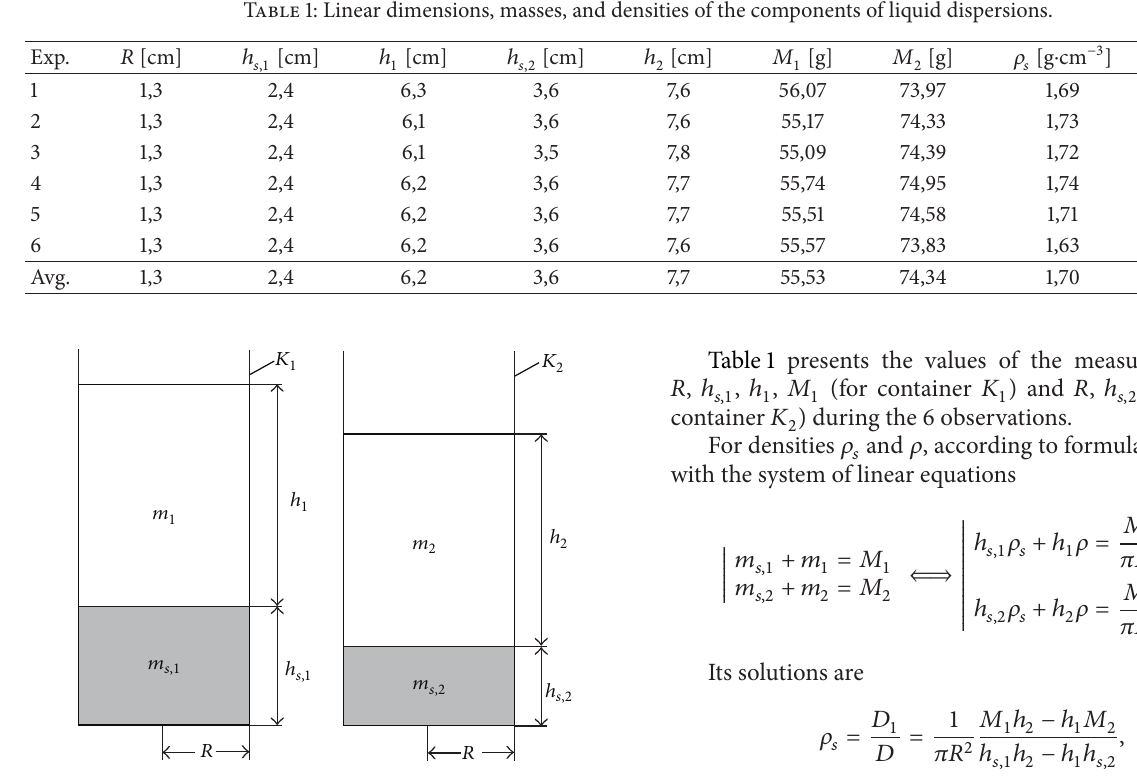
Figure 3: Vertical axial sections of two identical straight cylindrical containers with ultimate